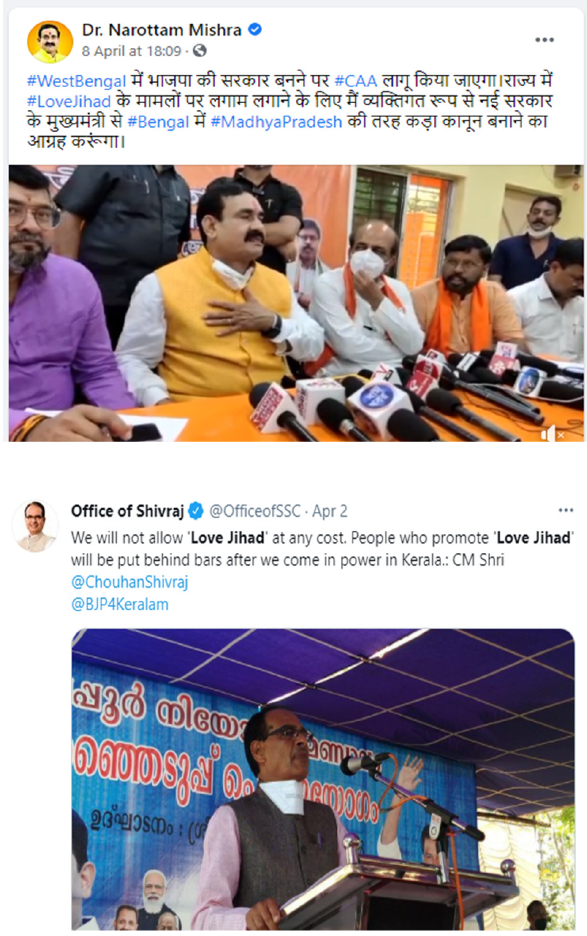
Figure 11. Tweets by BJP senior leaders during election campaign in April 2021, promising legislation against ‘love jihad’ if BJP is elected. Home Minister Narottam Mishra in West Bengal ( top ) and Chief Minister Shivraj Chauhan ( bottom ) at a rally in Kerala. Two BJP-ruled states, Uttar Pradesh (hereafter UP) (The Leaflet 2020) and Madhya Pradesh (hereafter MP) (Singh 2020b), both passed anti-conversion legislation with